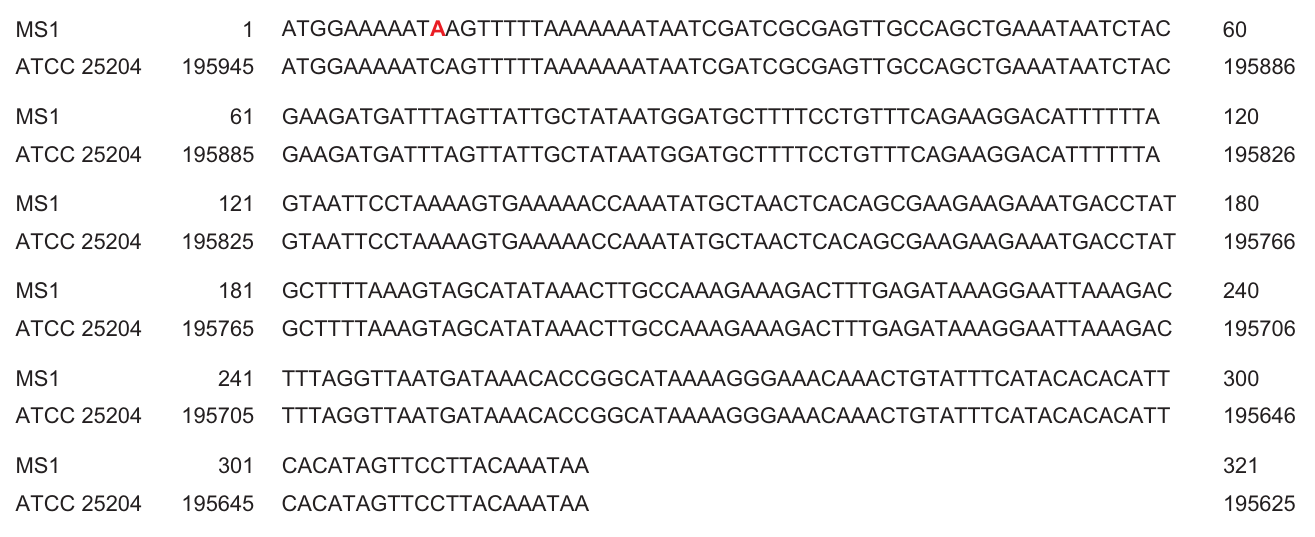
Fig 1. Sequence alignment of the HIT family protein coding gene of the MS1 vaccine strain and its parent strain ATCC 25204. Nucleotide polymorphism at 11. position (red) results in premature stop codon in strain MS1.